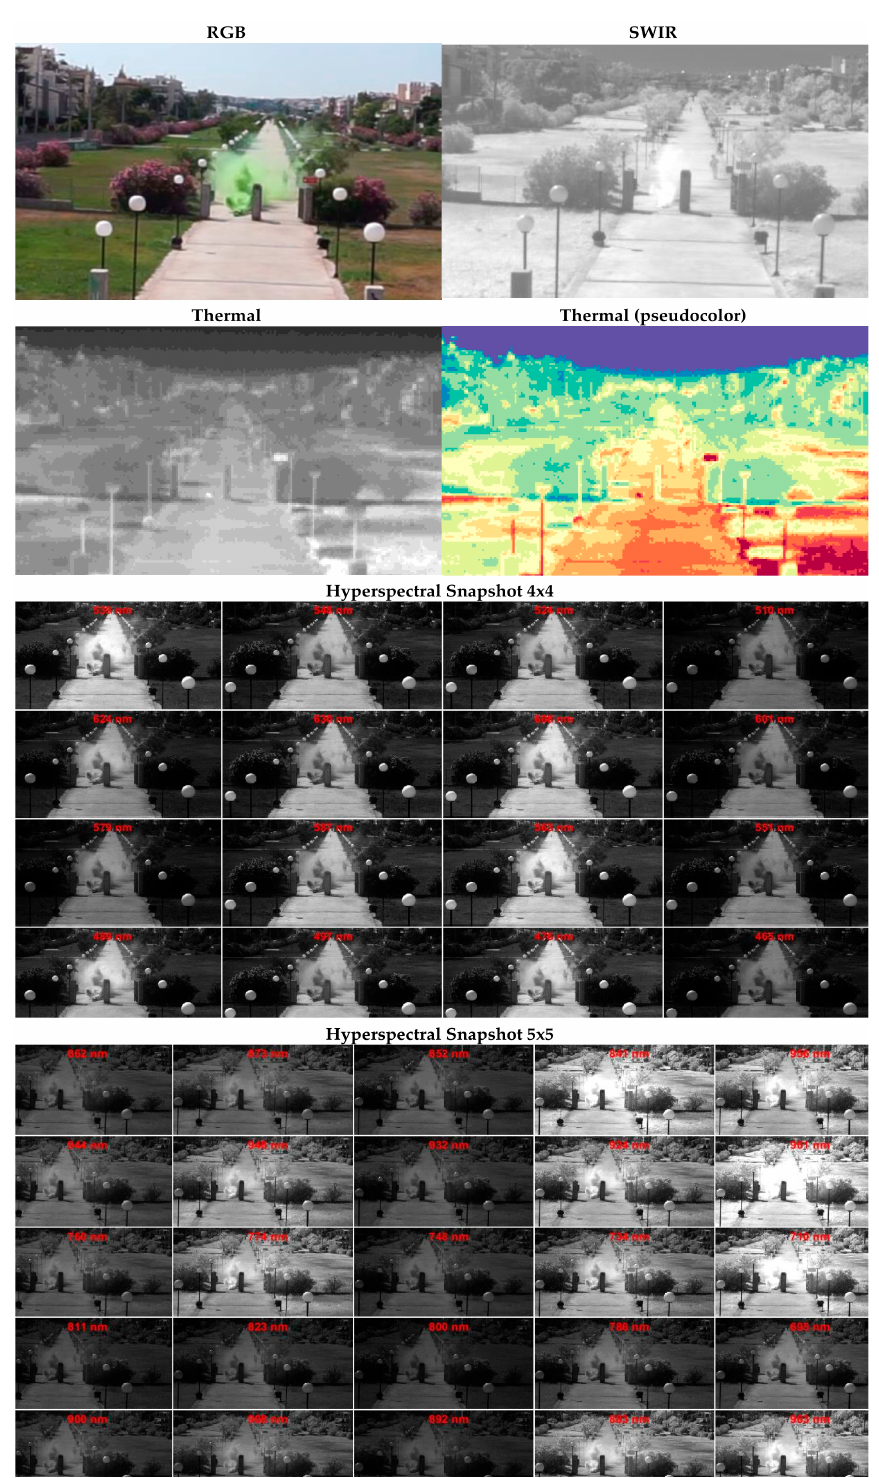
Figure 3. The concurrently acquired multimodal imaging data from the developed multisensor system including the SWIR, thermal, and the two hyperspectral (4 × 4 and 5 × 5 snapshot mosaic) sensors. The corresponding frame from a standard RGB optical CCTV sensor is presented (top left), as well.